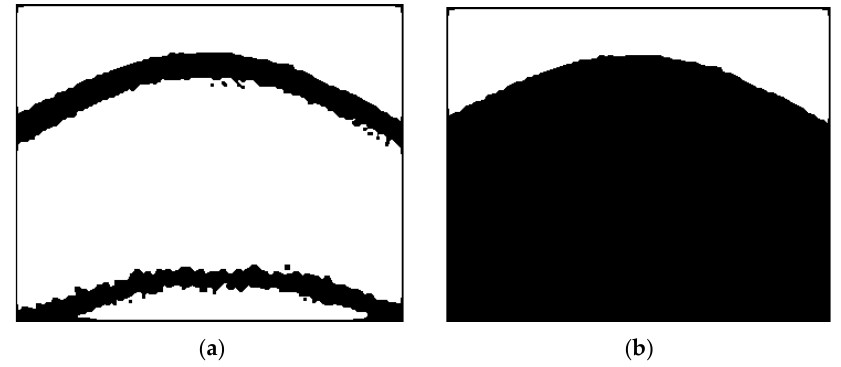
Figure 6. An example of the fingertip curved region detection procedure on a fingertip image obtained from a smartphone video camera: ( a ) non-trivial three regions (white) are found in an inverting smoothed image and ( b ) one representative region having the largest d avg is found.